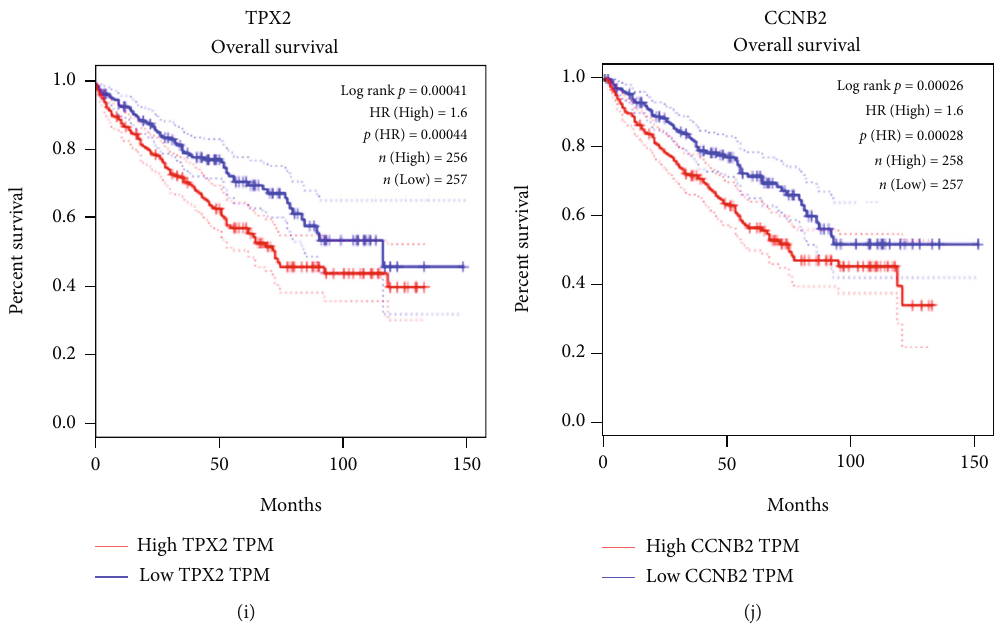
Figure 7: OS analysis of ten hub genes in KIRC (TCGA data in GEPIA). The expression of (a) KIF20A, (b) UBE2C, (c) CCNA2, (d) TOP2A, (e) PLK1, (f) RRM2, (g) CDC20, (h) AURKB, (i) TPX2, and (j) CCNB2 was highly related to OS rates of KIRC